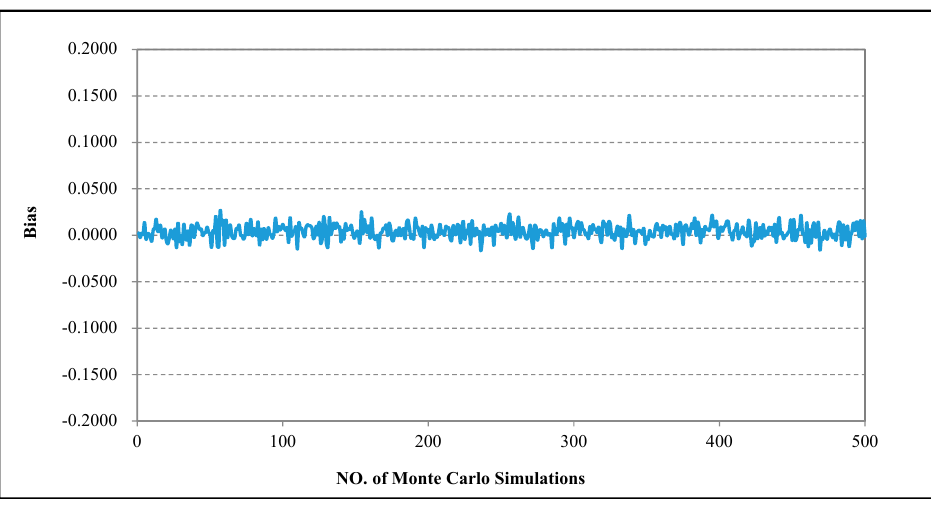
Figure 12. Bias analysis of proposed method in 14 bus system.